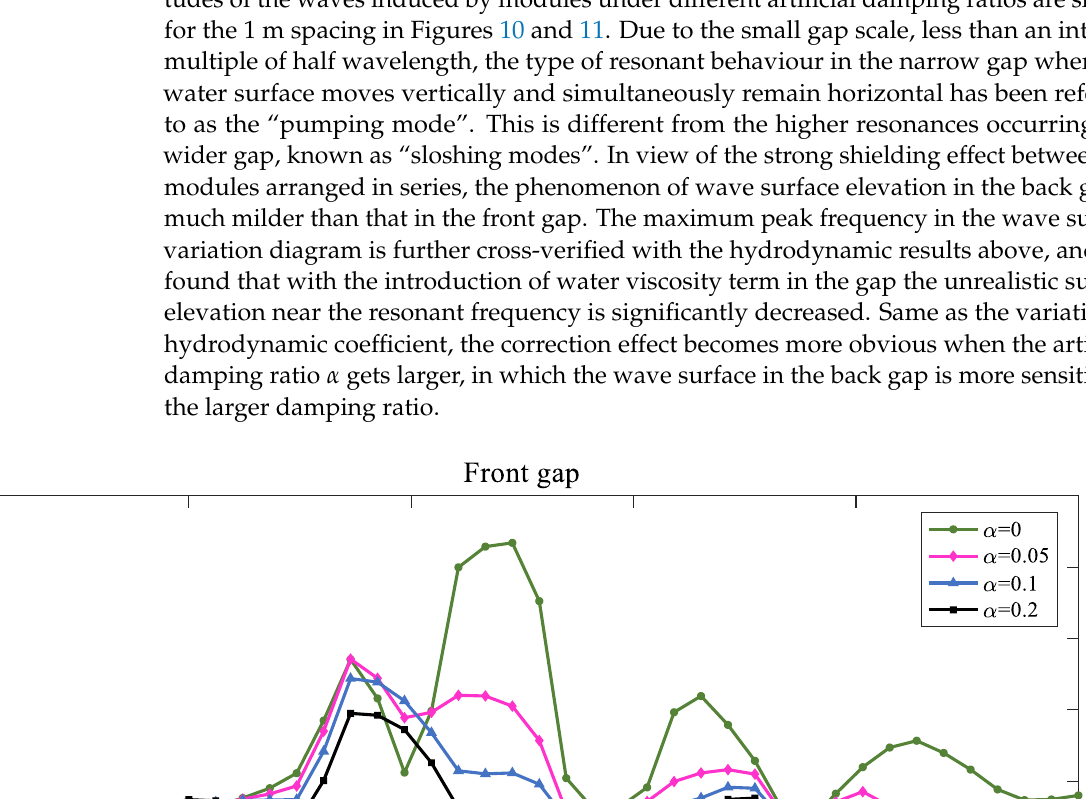
Figure 9. Windward module hydrodynamic coefficients with different artificial damping ratios, α , in 3- module model.